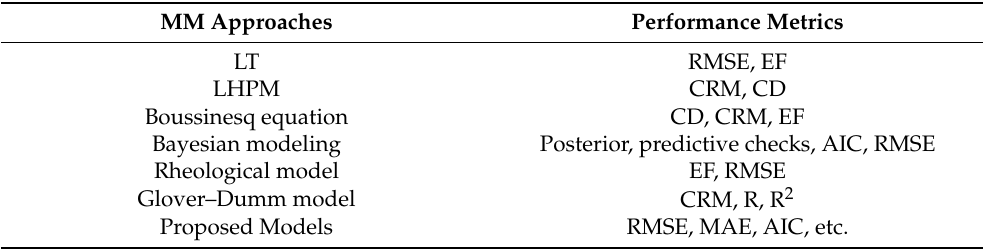
Table 7. MM approaches and performance